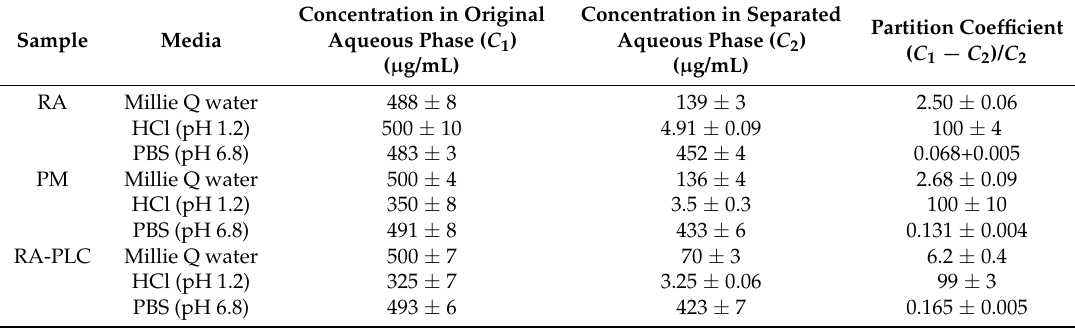
Table 1. 1-Octanol/water partition coefficient of RA, physical mixture (PM), and RA–PLC in different aqueous phases ( n = 3, mean ±